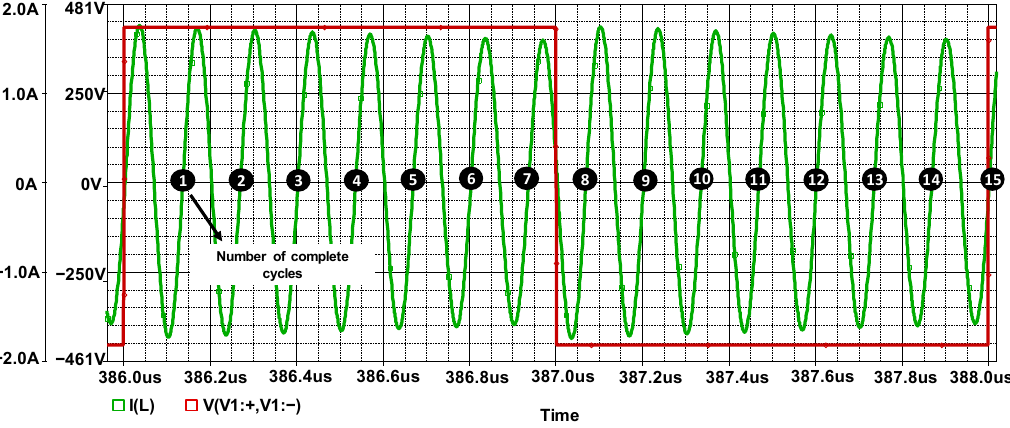
Figure 13. Current in the resonant tank (sinusoidal waveform) with “ n ” complete cycles in one cycle of the bipolar voltage source (square waveform).